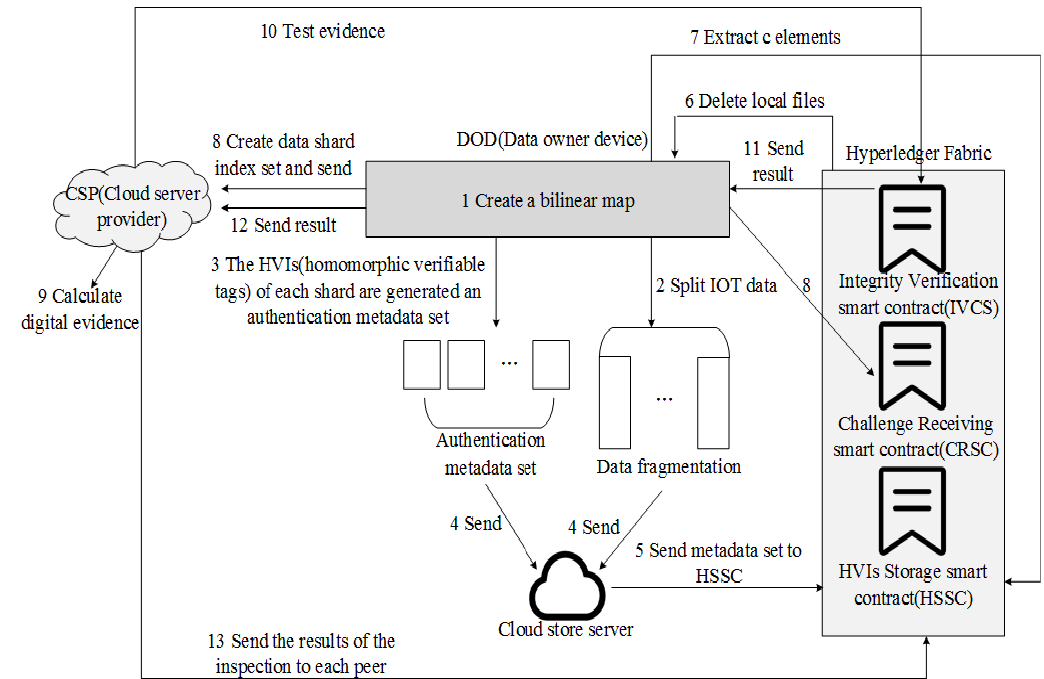
Figure 1. Reconstruction diagram of reference [22].